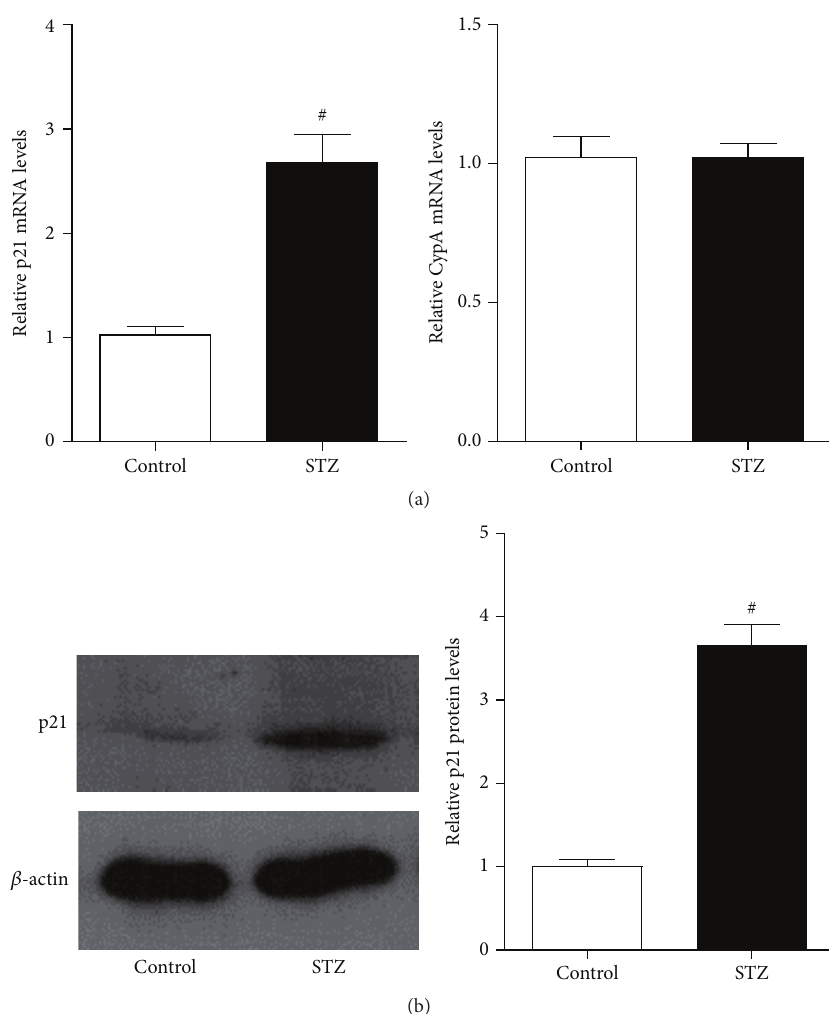
Figure 1: Results of p21 gene expression in the glomeruli of type 1 diabetic rats. (a) Eight weeks after male Wistar rats were successfully induced to be diabetic models with STZ (55 mg/kg), mRNA levels of p21 gene and housekeeping gene cyclophilin A (CypA) of glomeruli in control and STZ groups were analyzed by RT-qPCR. Gene expression was normalized to internal control 𝛽 -actin gene; results were expressed as fold over control (mean ± SEM; # 𝑃 < 0.05 compared to control, 𝑛 = 6 /group). (b) Western blot analysis of extracted proteins from control and STZ groups glomeruli using p21 and 𝛽 -actin antibodies; quantitative analyses were expressed as fold over control (mean ± SEM; # 𝑃 < 0.05 compared to control, 𝑛 = 6